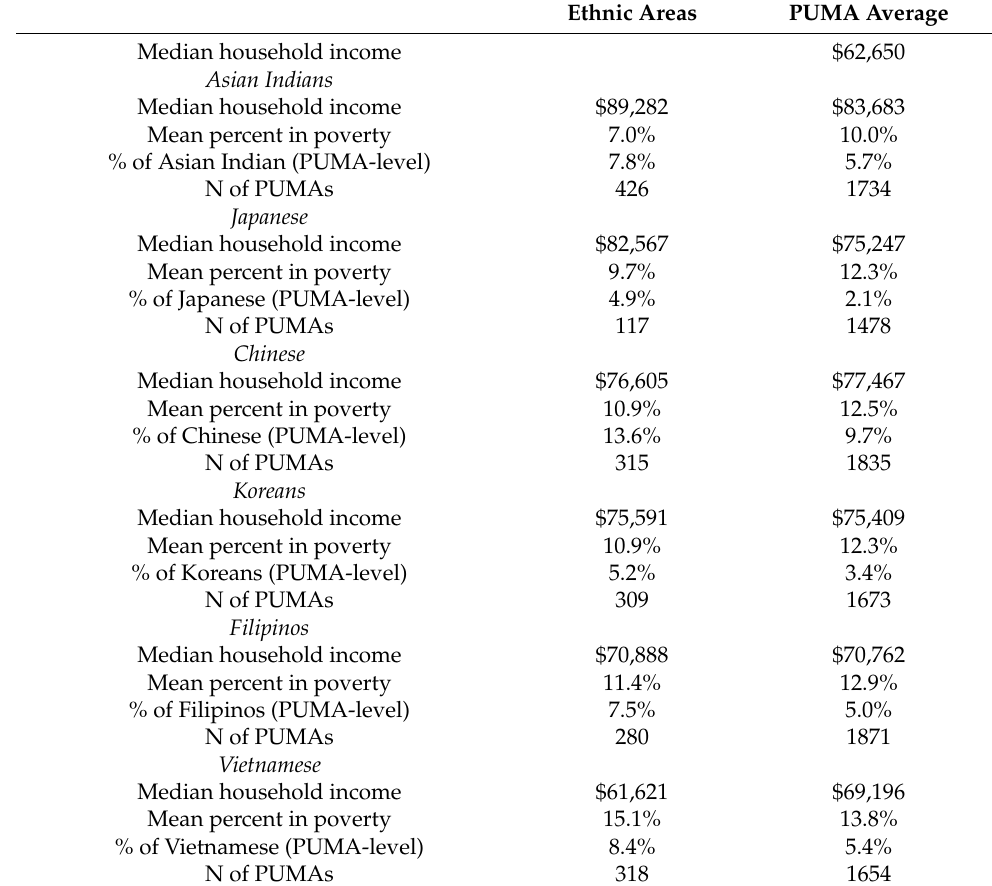
Table 1. Descriptive Statistics and Characteristics of Ethnic Areas and PUMA Average, 2013–2017. Ethnic Areas PUMA